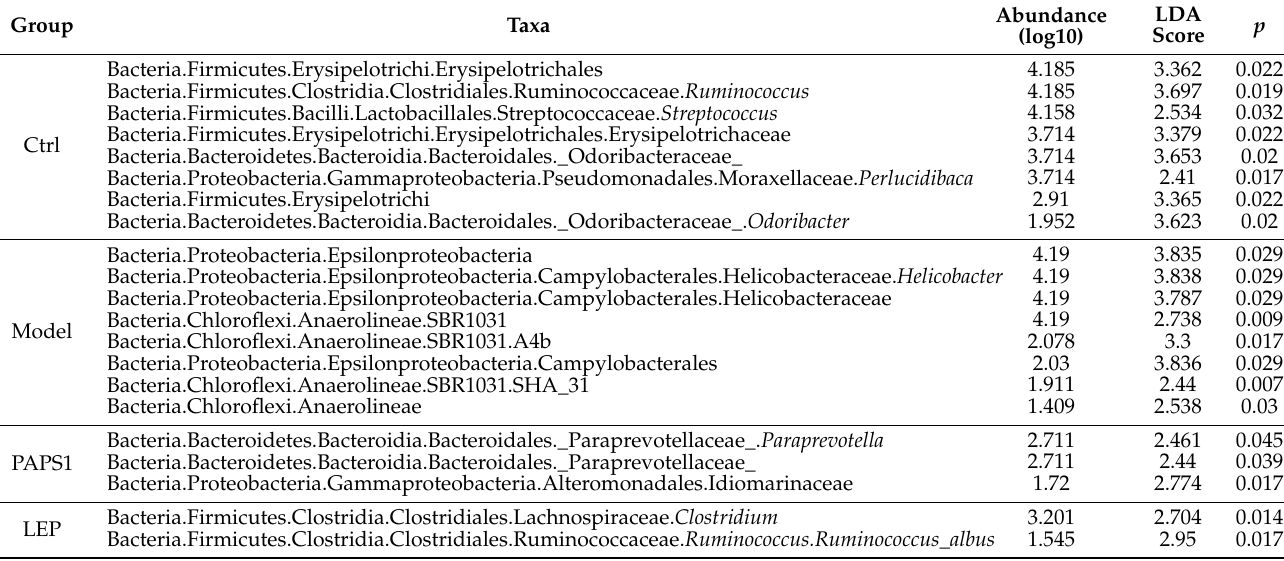
Table 3. Dominant nodes of intestinal microflora in